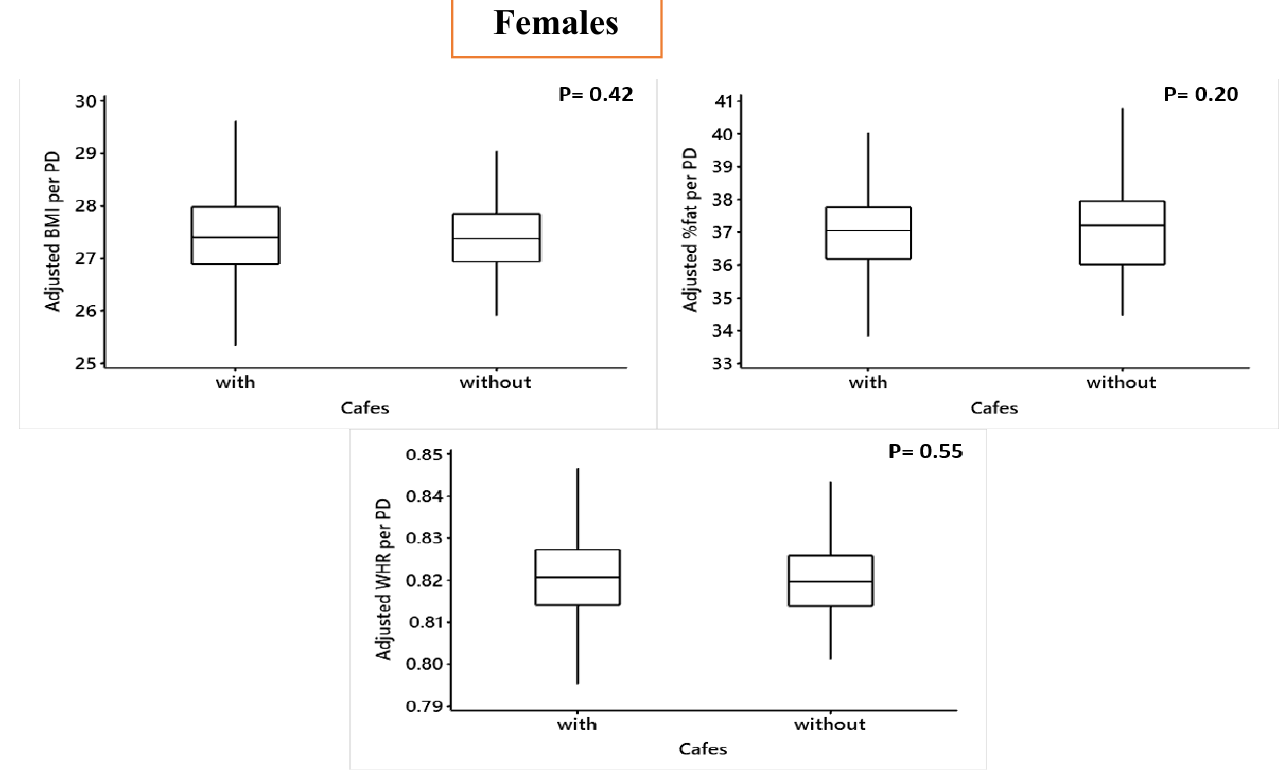
Figure A3. Comparing the adjusted means of BMI, WHR and %fat for males and females in PDs in which some of the given food outlet types were present or absent. Obesity measures adjusted for deprivation level per household, education, employment, ethnicity, household size, household income and age. BMI = Body Mass Index, WHR = Waist to Hip Ratio. Males: A = fish & chip shops, B = Fast-Food Restaurants, C = Delivery shops, D = Takeaways, E = Pubs, F = Cafes; Females: G = Delivery shops, H = Takeaways, I = Pubs, J = Cafes.